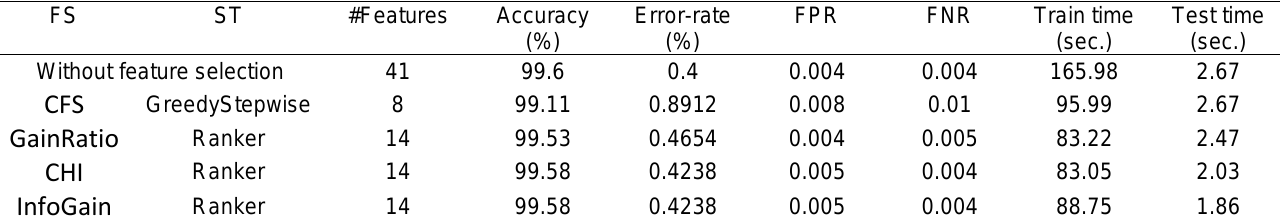
Table 7. Performance evaluation of Random Forest classifier using and without using feature selection techniques